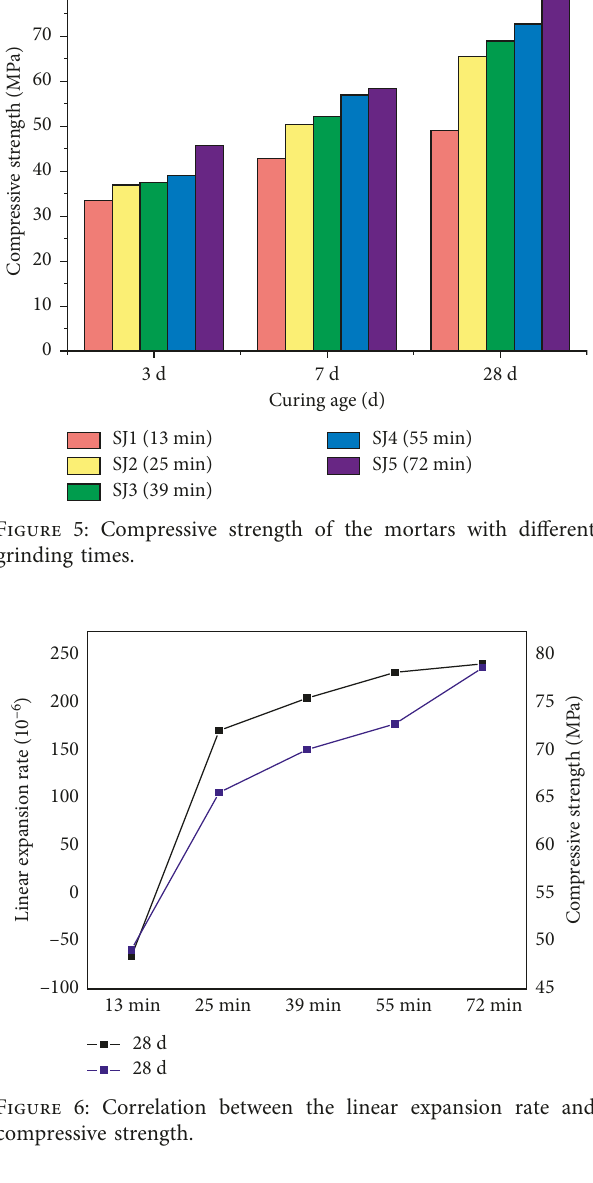
Figure 8: XRD patterns of the mortars with different grinding times at 28d